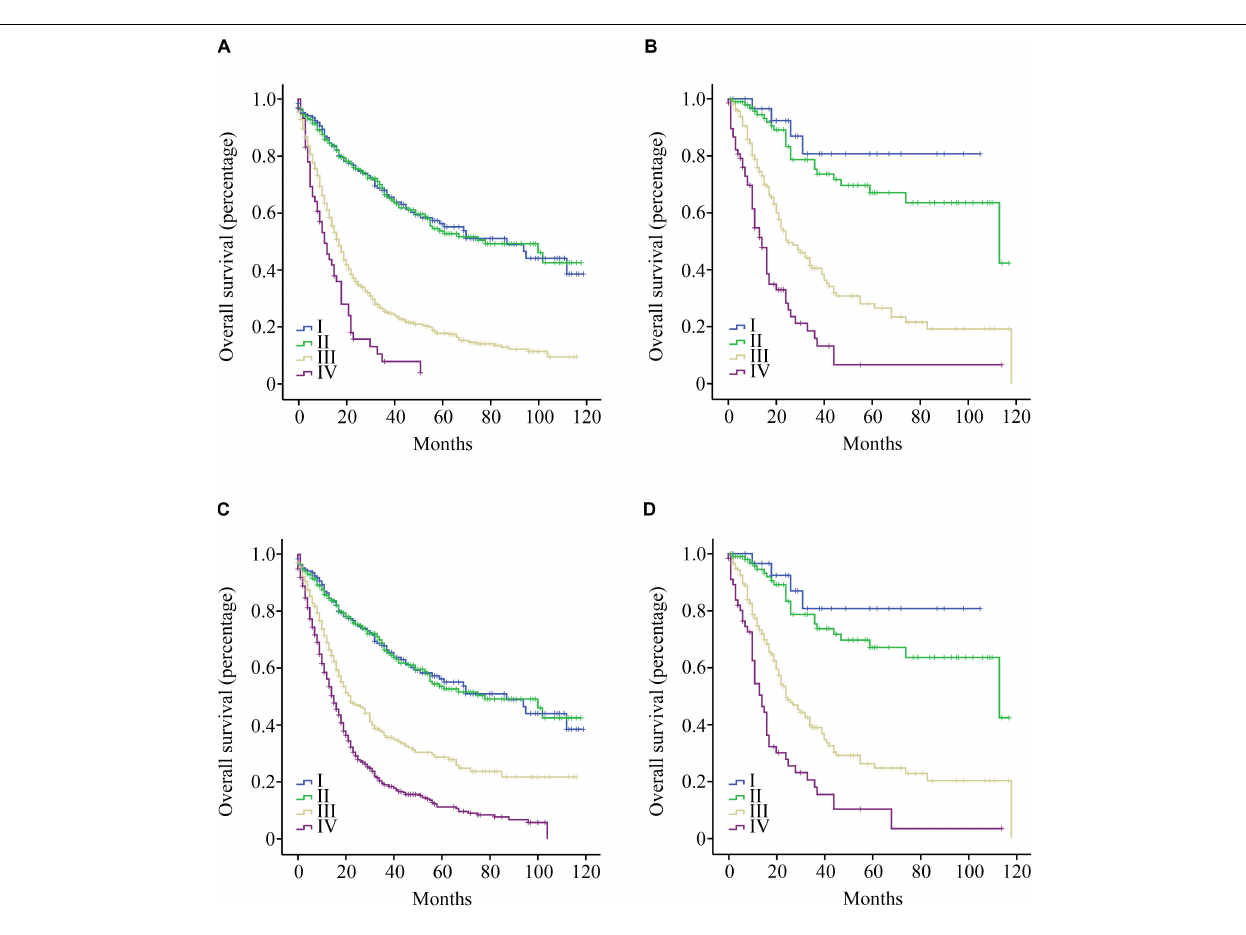
Frontiers in Oncology | www.frontiersin.org